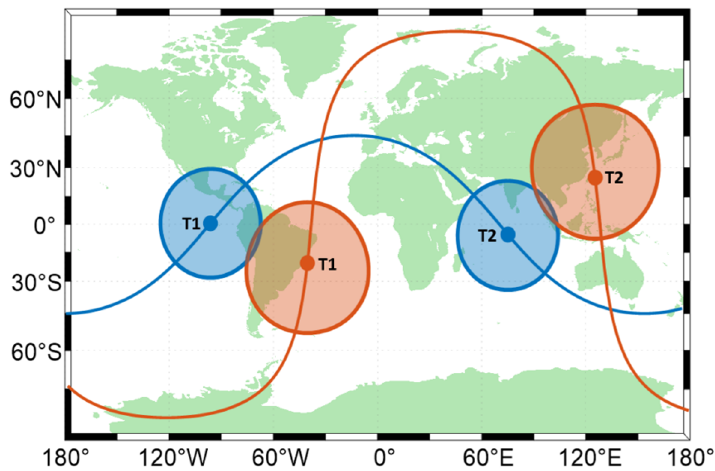
Figure 15. Diagram of sub-satellite points in different satellite orbits. These two different colors represent two satellites with different orbits . The points are satellite positions. The circles show the range in which the satellite PRN codes can be received on the ground.